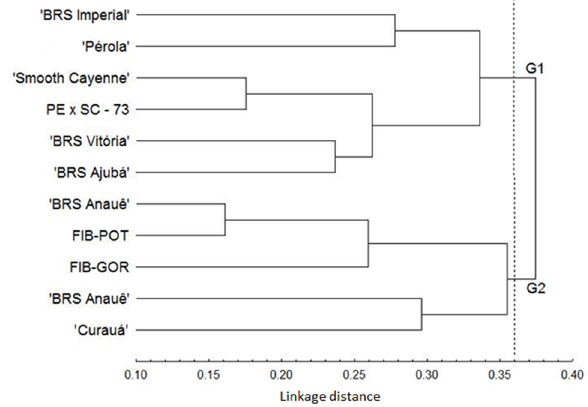
Figure 5 - Dendrogram of the 11 pineapple genotypes based on the gower algortithm (gower 1971): combined molecular and phenotypic data for fiber quality. The UPGMA method was used to define the groups and cutoff points were defined according to the pseudo t 2 parameters (Duda and Hart